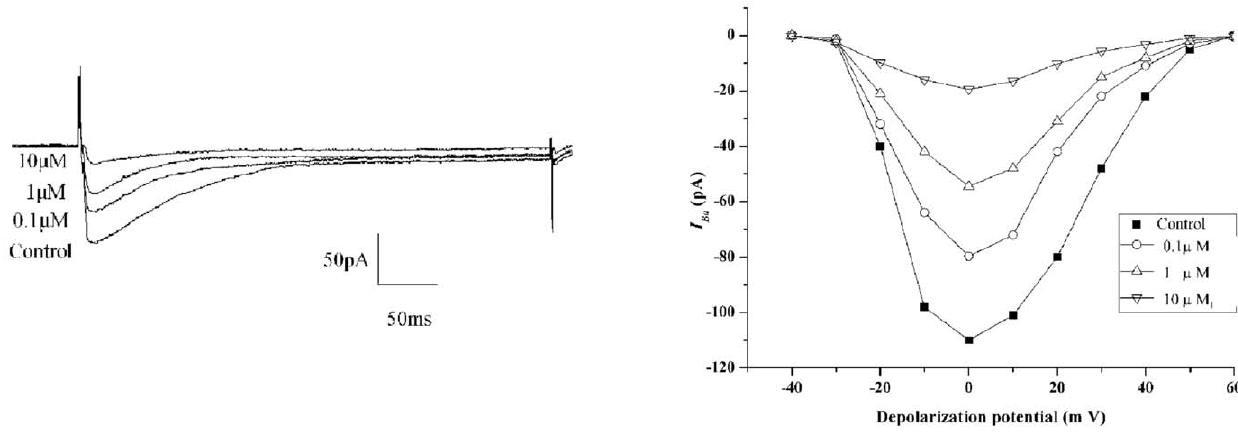
Figure 6. Effect of 16c on L-type Ca 2 + channel currents in vascular smooth muscle cells (A) and on I–V relation of Ba 2 + currents in vascular smooth muscle cells (B). The step protocol of recording was described in methods